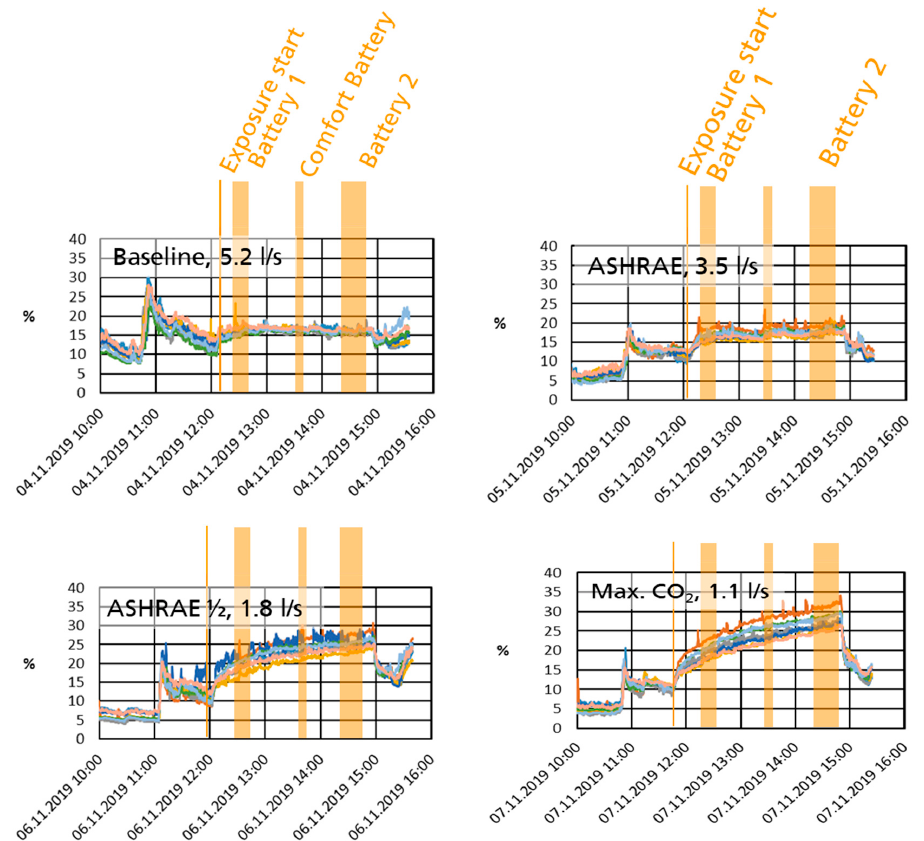
Figure 10. Transient evolution of relative humidity in the cabin for four different test days with different outside airflow rates.